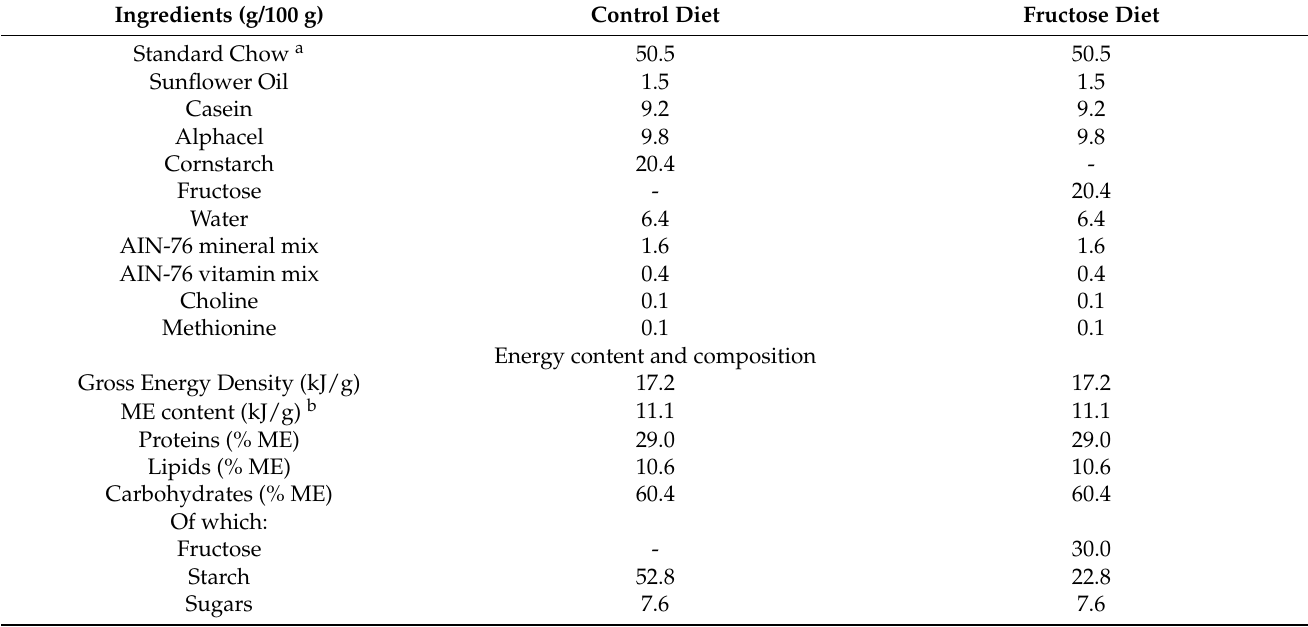
Table 1. Nutritional composition of